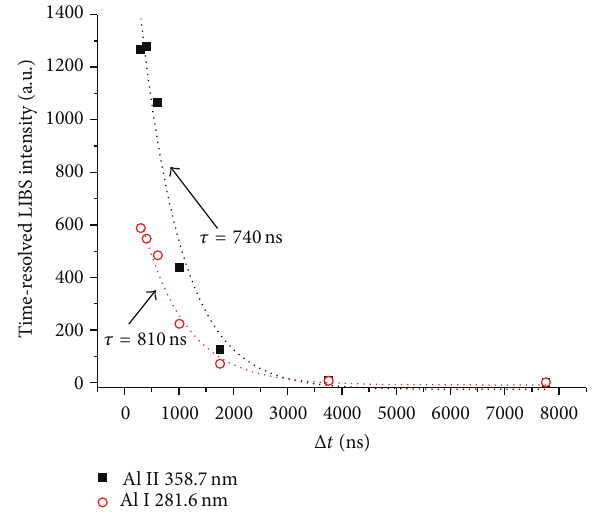
Figure 6: Dependence of the total LIBS intensity on the acquisition delay.Thedottedcurvesarethebestfitwithanexponentialfunction. Red circles: time-integrated spectra; black squares: time-resolved spectra.